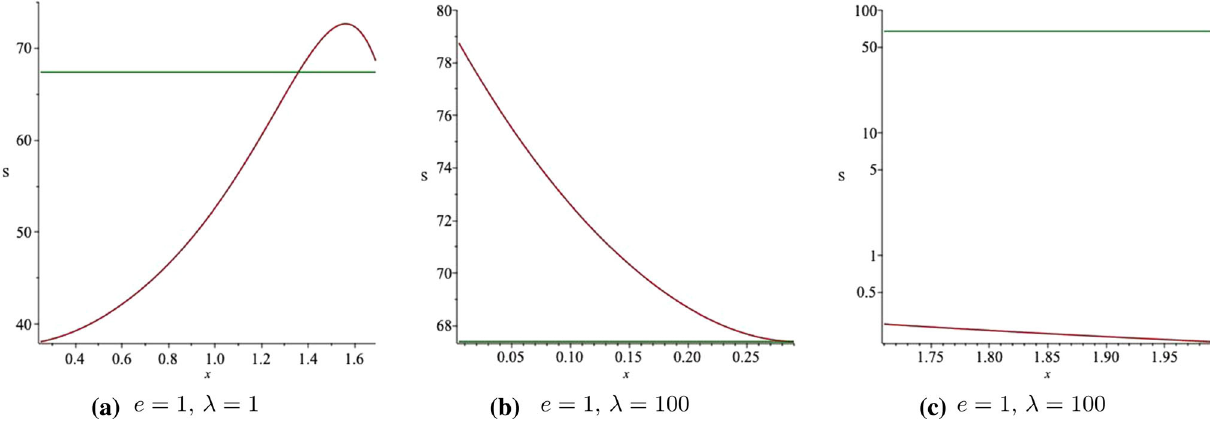
forbidden. In a , the type I is favored for x < 1 . 359 and the type II is favored for x > 1 . 359. In b , the type II always prevails, and in c , the type I is always